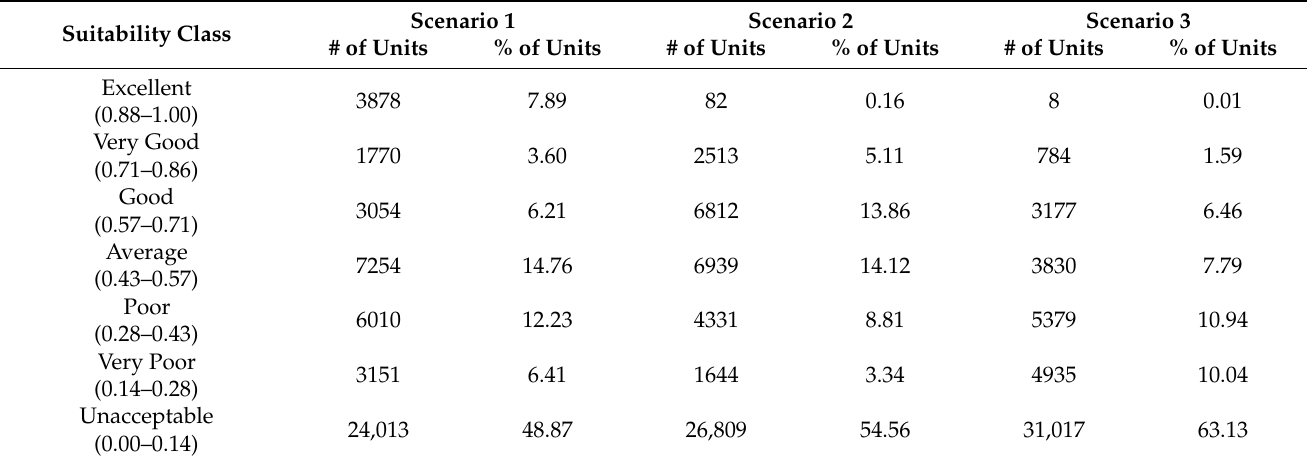
Table 3. Number and percentage of units in each value class by